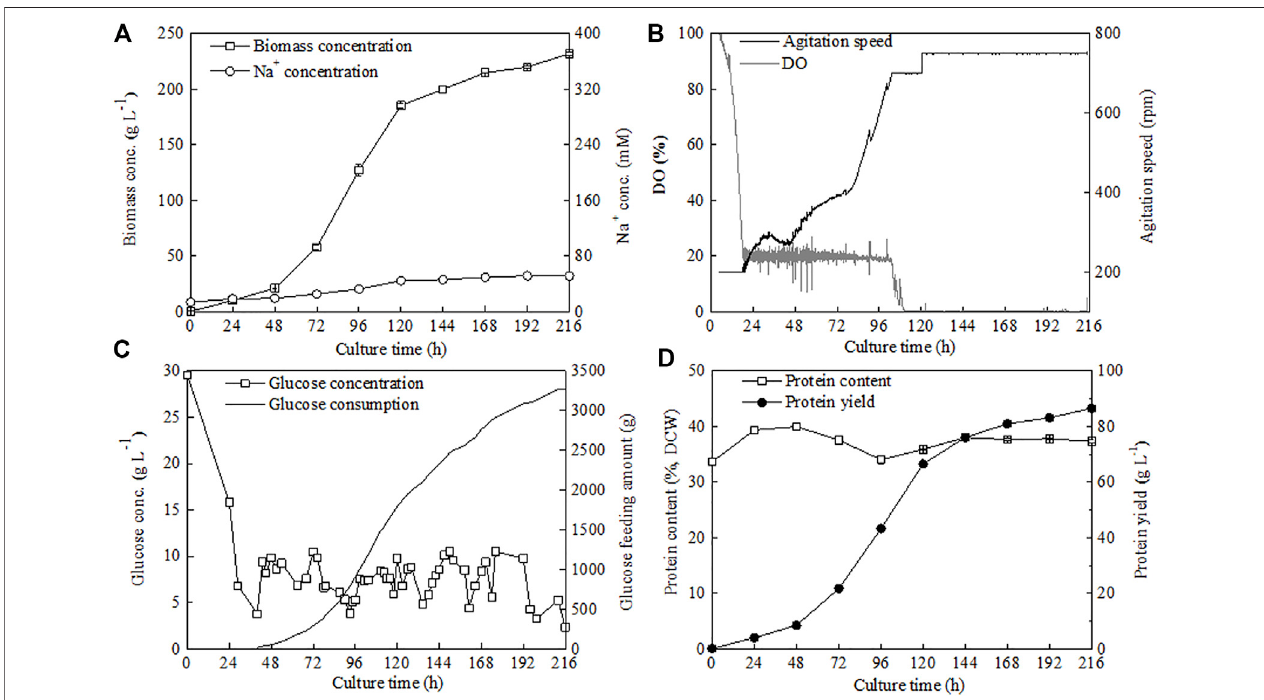
FIGURE 6 | Time courses of biomass and Na + concentrations (A) , DO and agitation speed (B) , glucose consumption and glucose concentration (C) , and protein content and protein yield (D) under novel N supply strategy by reducing the N concentration of feeding medium and adjusting pH with ammonium hydroxide.